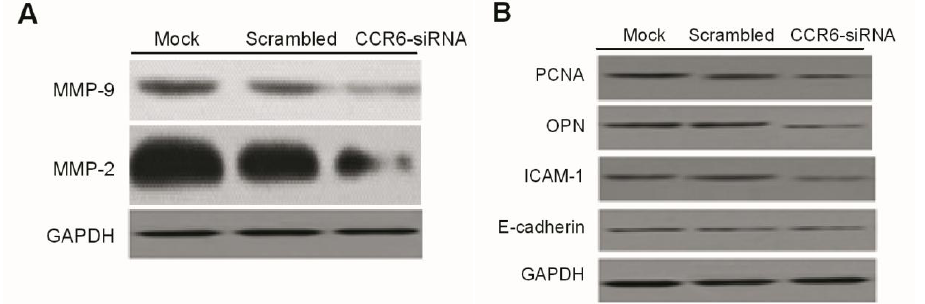
Figure 6. The release of MMP-2, MMP-9 ( A ) and the expression of PCNA, ICAM-1 and OPN ( B ) in the HCCLM6-mock group, the HCCLM6-scrambled group and the CCR6-siRNA